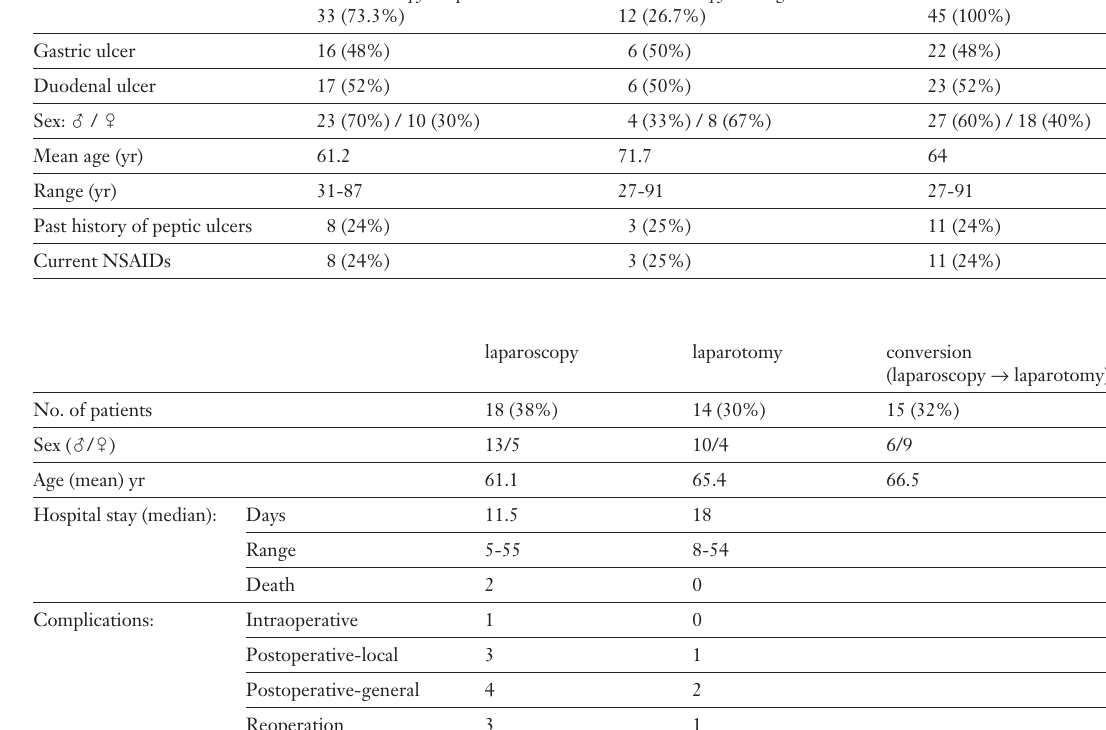
Comparison of the patients with perfo- rated peptic ulcers found to be positive and negative for Helicobacter pylori by intraoperative CLO test (n = 45).